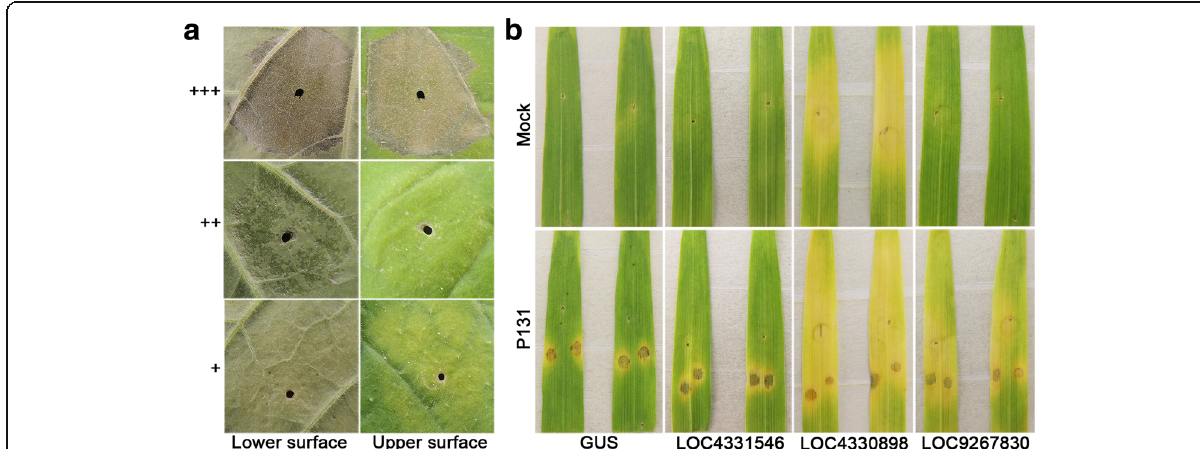
Fig. 5 Transient gene expression assays on N. benthamiana and barley plants. a Cell death was induced by candidate clones on the upper and lower surface of leaves on N. benthamiana plants as indicated. The Agrobacterium suspensions in 10mM MgCl 2 (OD 600 >0.5) were infiltrated with a needleless syringe into leaves of N. benthamiana plants, and the infiltrated plants were incubated at 24°C in a growth room with a 16-h light/8-h dark cycle. Photos were taken at 5days after infiltration. b Chlorosis was induced on barley leaves by transient expression of candidate genes without (Mock) and with (P131) the inoculation of the blast fungus strain P131. The β -glucuronidase (GUS) and LOC4331546 represent proteins incapable of inducing chlorosis. LOC4330898 and LOC9267830 represent proteins capable of triggering leaf chlorosis without or with subsequent blast fungus inoculation, respectively. Detached barley leaves transiently expressing candidate genes were inoculated with blast fungus strain P131 (5×10 5 spores/ mL) and incubated in a growth chamber at 26°C with a photoperiod of 16-h light/8-h darkness. Representative leaves were photographed at 96h after inoculation. The experiment was repeated three times and similar results were observed. “ +++ ” indicates tissue collapse of the Agrobacteria - inoculated region; “ ++ ” and “ + ” indicate partial or sporadic cell death, respectively, observed on the lower surface of